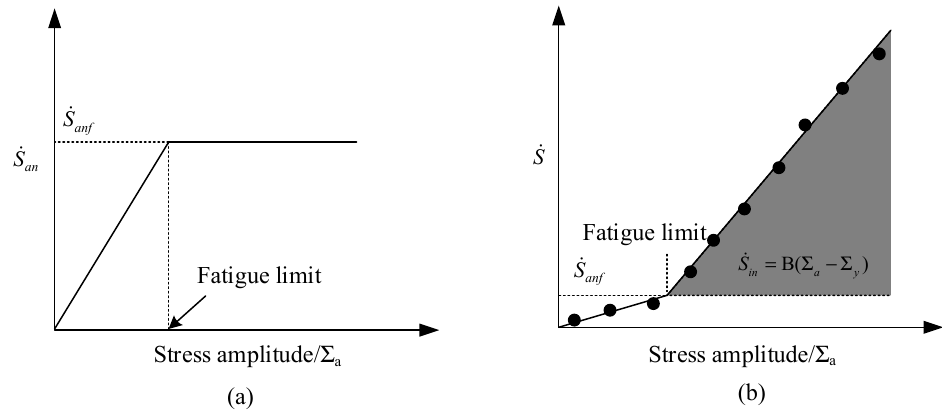
Figure 4. The entropy generation rate induced by inelasticity and anelasticity during HCF: ( a ) entropy production rate caused by anelasticity during HCF; ( b ) fatigue limit prediction model.